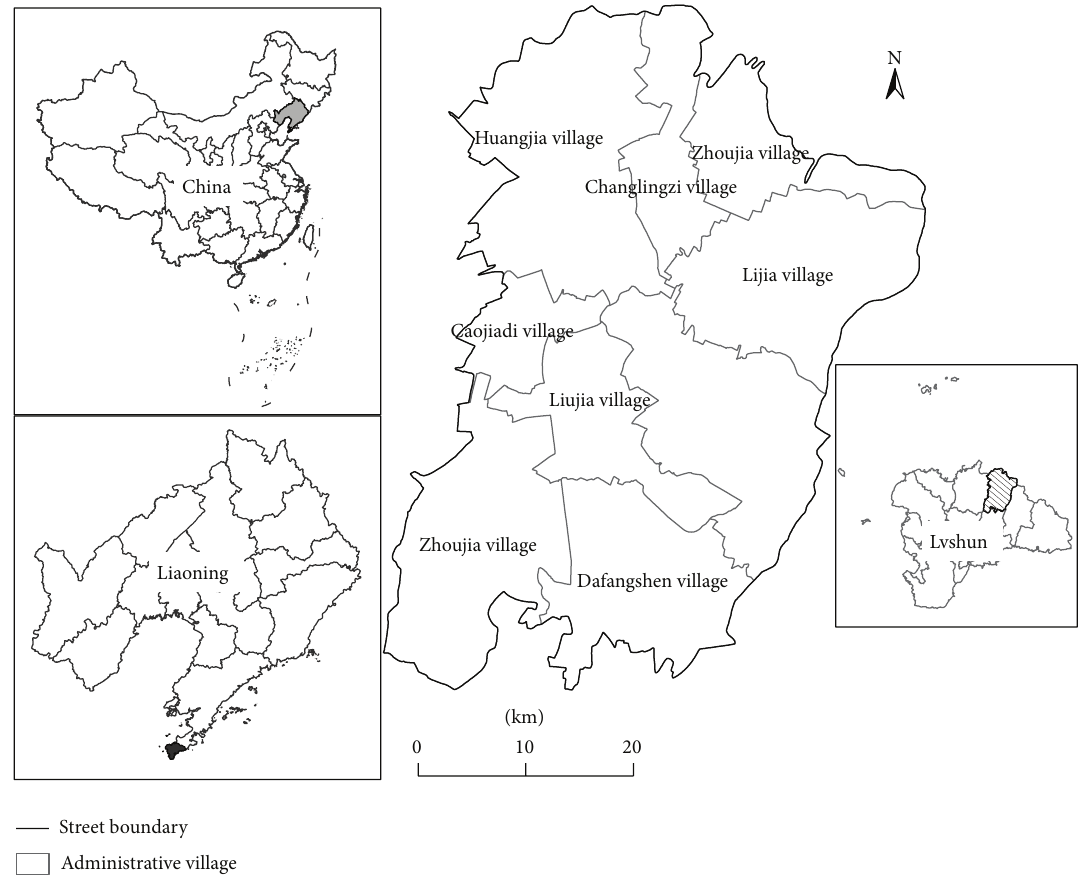
Figure 4: Location of study